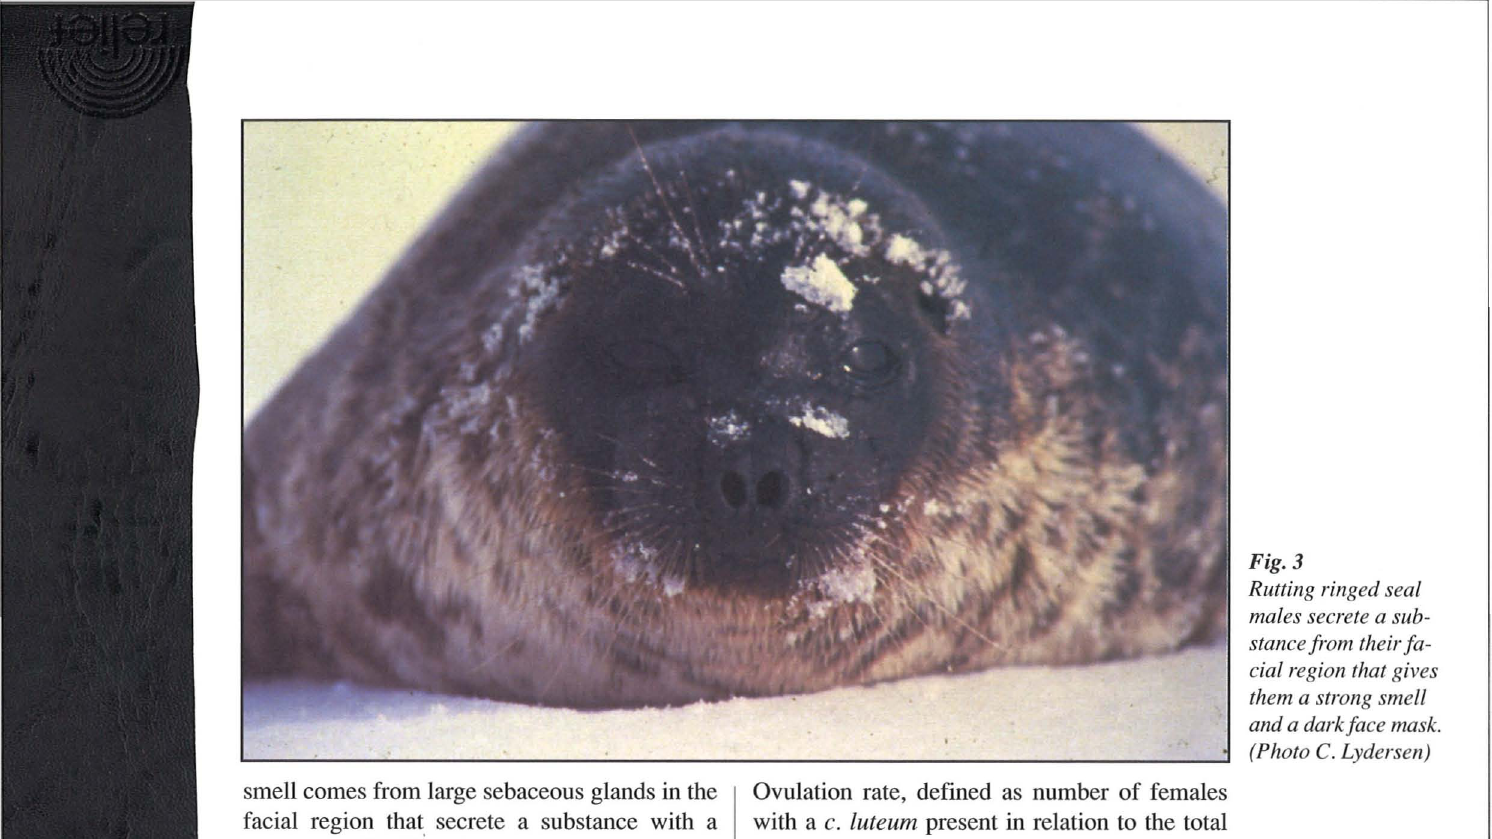
Fig. 3 Rutting ringed seal males secrete a sub stance from their fa cial region that gives them a strong smell and a darkface mask. (Photo C.